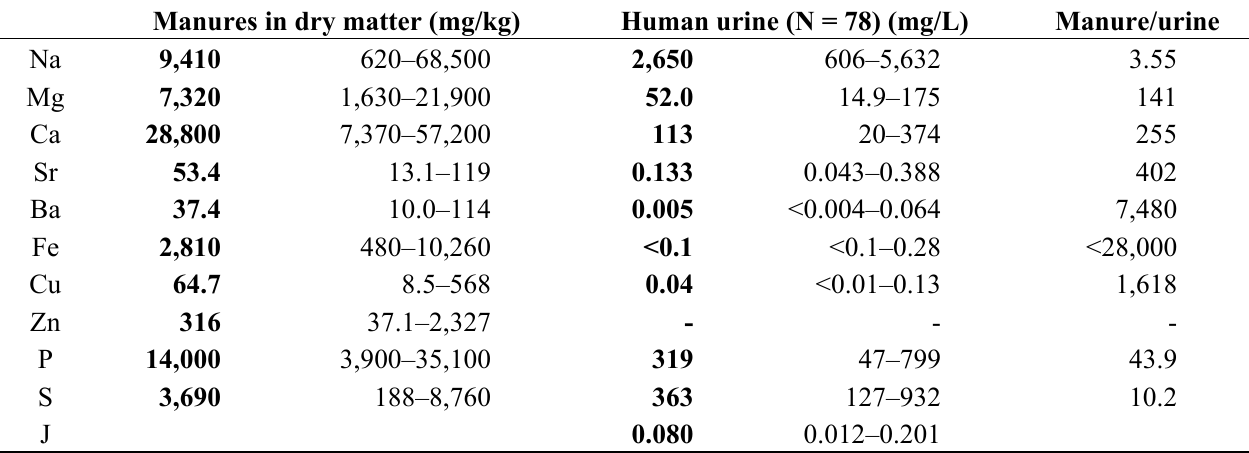
Table 4. Concentrations found in manures of domestic animals versus human urine. Manures in dry matter